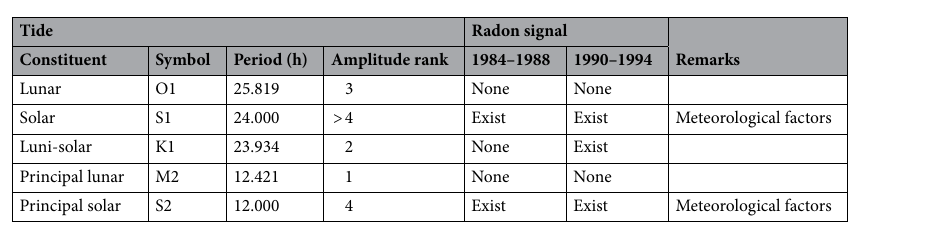
Figure 2. Time-series variations in atmospheric radon concentration observed at KPU. ( a ) Time-series variation drawn using hourly original data. ( b ) Time-series variation drawn using detrended data of smoothed daily minimum radon concentrations. The smoothed daily minimum values were analysed because of those less sensitive to daily variations in meteorological factors (e.g., wind speed, thermal stabilisation).